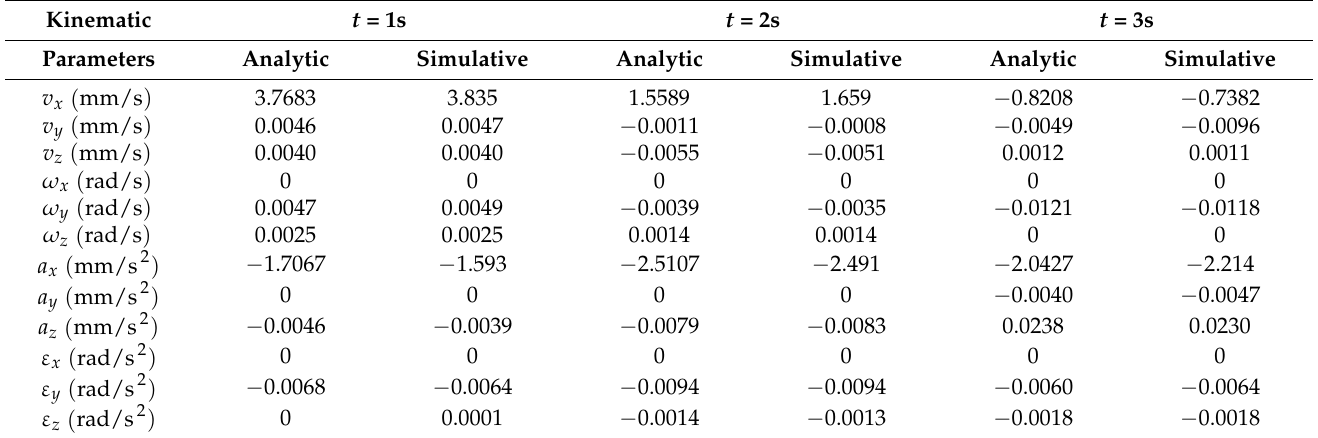
Table 4. The comparison of simulative and analytic values of kinematic